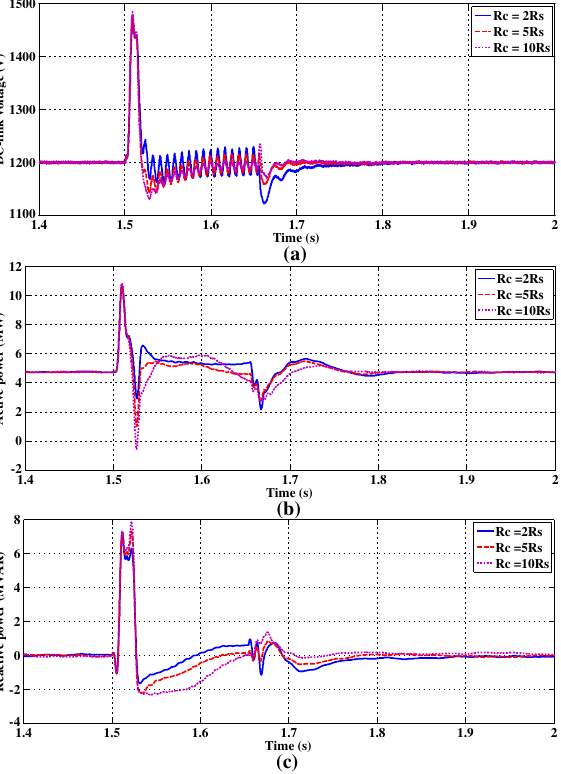
Fig. 12 Variation of measured values during single-phase to ground fault with different CBFT resistances ( a ) DC-link voltage; ( b ) active power; ( c ) reactive power